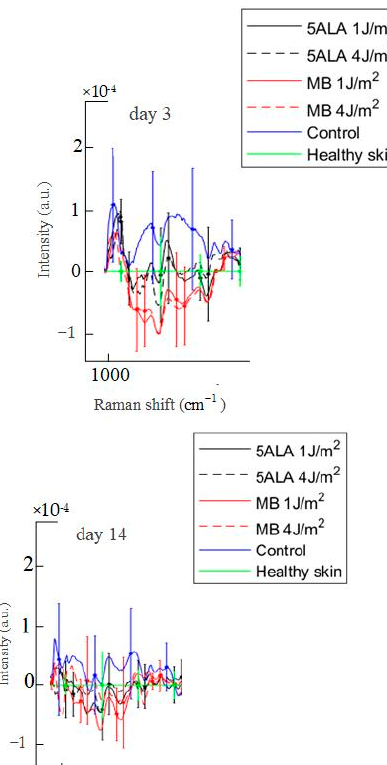
Figure 11. Differences between the wound Raman spectra of all groups subtracting the healthy skin mean Raman spectrum. The Raman spectra are presented in terms of mean ± StD values. Black line—5ALA 1 J/cm 2 , black dashed line—5ALA 4 J/cm 2 , red line—MB 1 J/cm 2 , red dashed line—MB 4 J/cm 2 , blue line—control, green line—healthy skin (the number of processed Raman spectra was equal to 30 for each group).